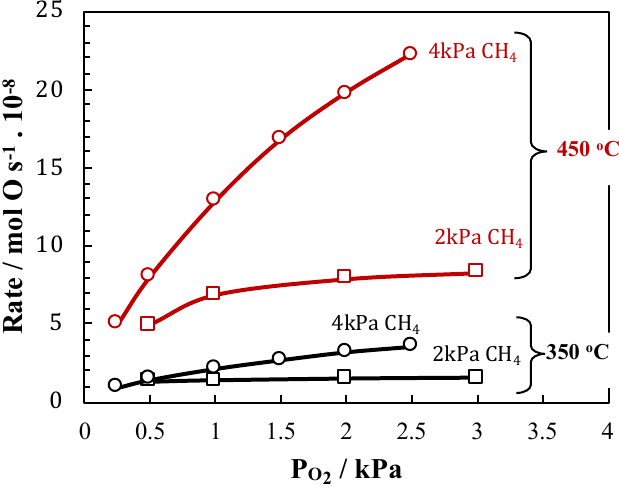
Figure 3. Effect of oxygen-to-methane ratio on catalytic rate at 350 and 450 °C.